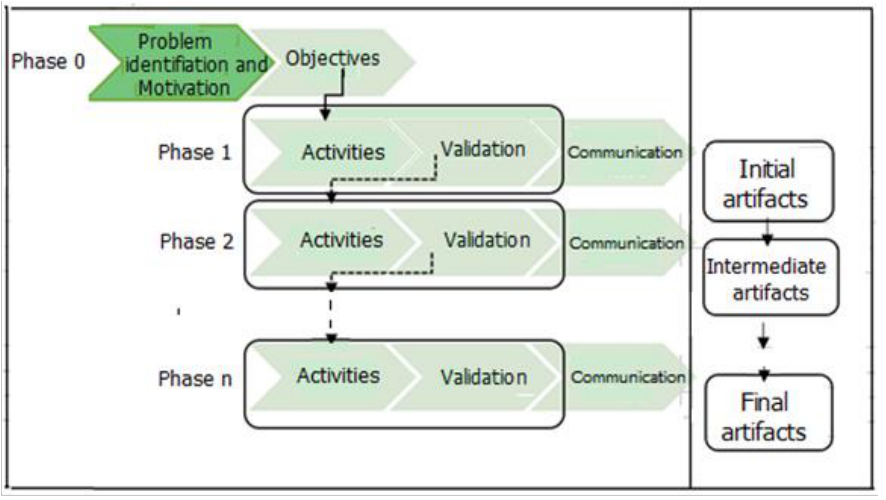
Figure 7. Design science research framework.